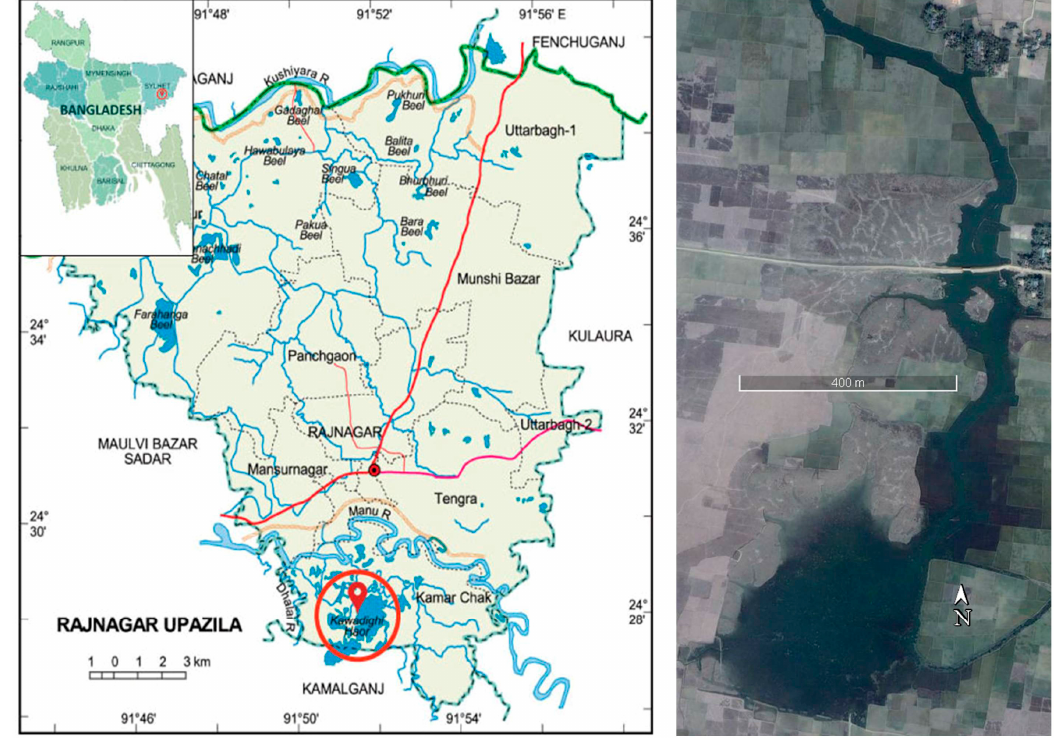
Figure 1. Location of the study area